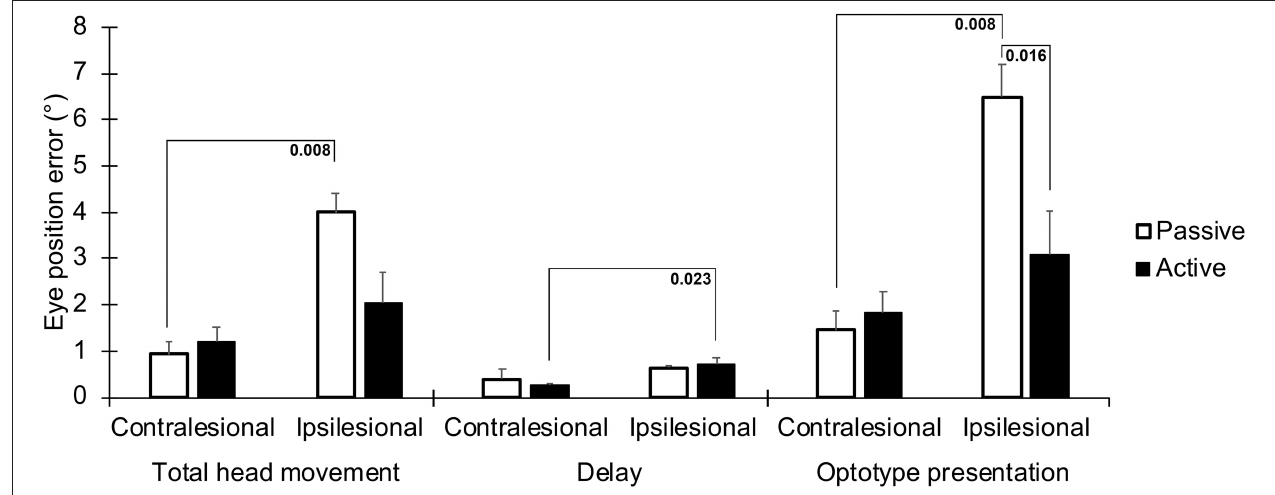
FIGURE 3 | Absolute position errors between the eyes and head, representing a drift of the eyes from the visual target the subjects were instructed to focus on during the head movement. Values are presented for the three time frames; during the total head movement, during the delay, and during the optotype presentation, for head movements in the ipsilesional and contralesional directions during active and passive head movements. Bars representing mean values for the group. Error bars indicate SEM. Bonferroni corrected post- hoc statistics presented numerically.